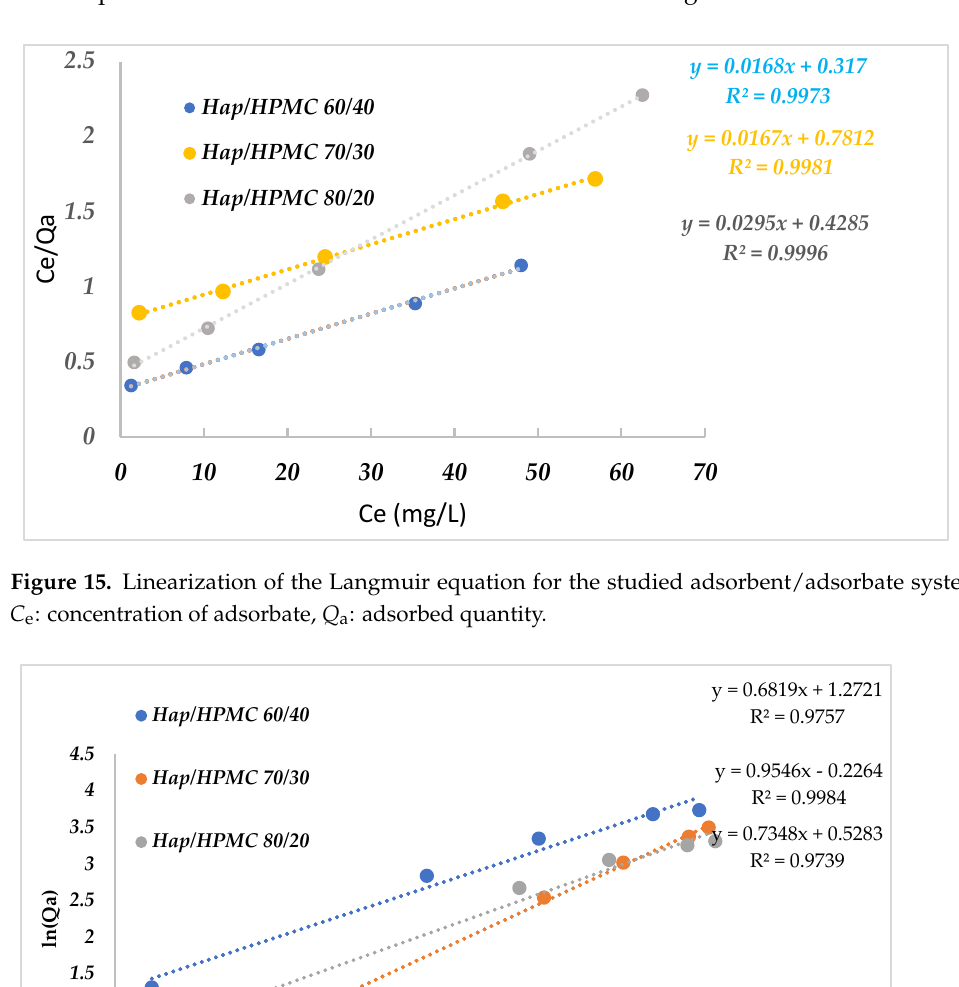
Figure 14. Evolution of the adsorbed quantity as a function of the MB concentration, pH = 7, T = 25 ± 2 °C and V rot = 250 rpm.